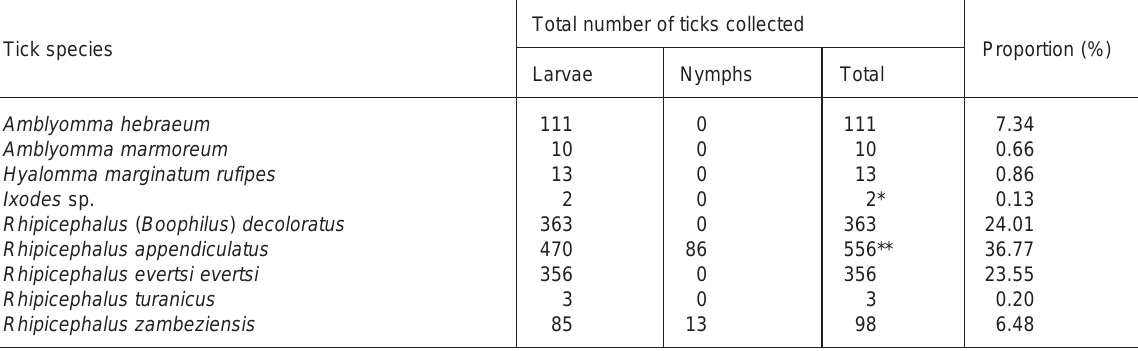
TABLE 3 Free-living ticks collected by drag-sampling the vegetation on the farm “Sandspruit”, Limpopo